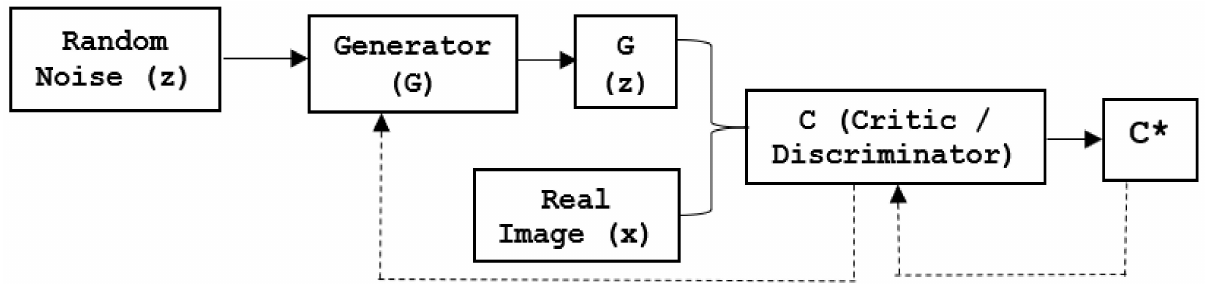
Figure 2. Schematic of the Wasserstein Generative Adversarial Network